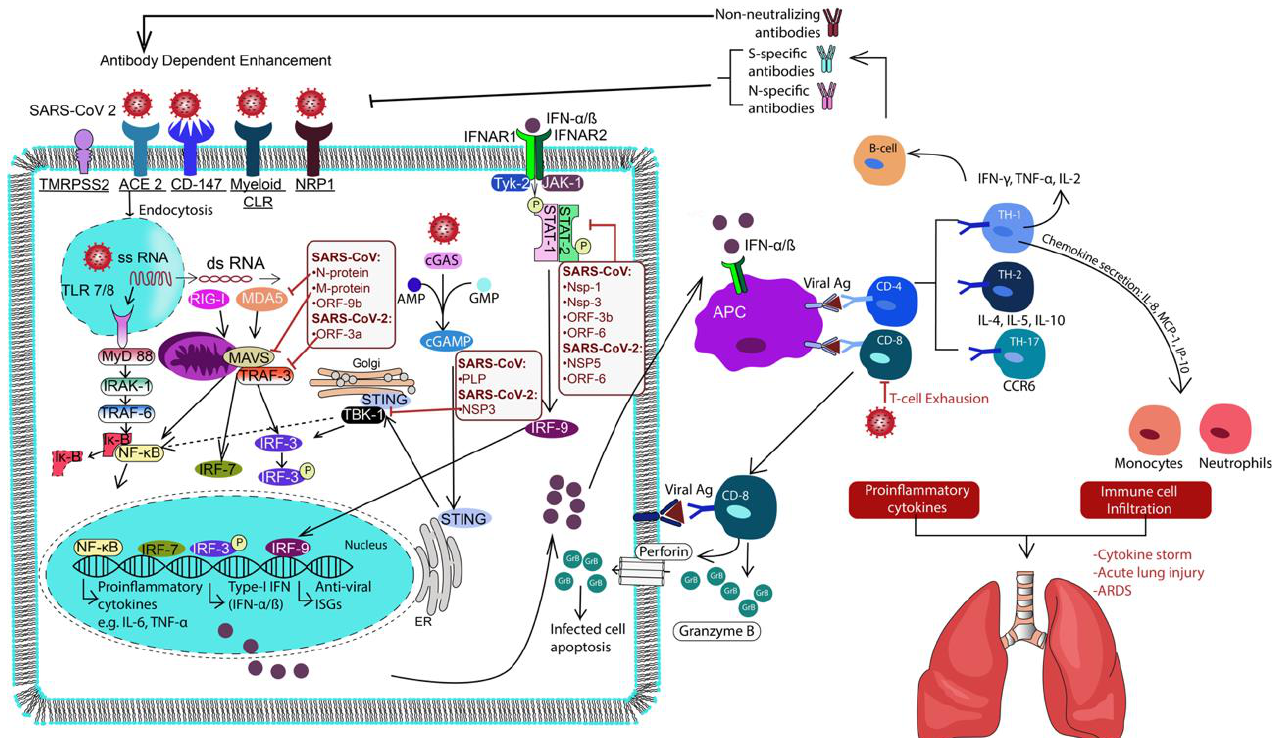
Figure 1. Schematic illustration overviewing Severe Acute Respiratory Syndrome Coronavirus-2 (SARS-CoV-2) infection mechanism and the host immune response post-infection. TMPRSS2, angiotensin-converting enzyme 2 receptor (ACE2) and CD147 play pivotal roles in the viral attachment and entry followed by post-infection and viral replication. Host immune defense begins sooner with the initiation of PRR signaling (TLRs, RLRs, CLRs and cGAS-STING) leading to activation of type I IFN along with proinflammatory cytokine. TLRs, Toll-like receptors; RLRs, RIG-1 like receptors; CLRS, C-lectin like receptors; cGAS-STING, cyclic GMP-AMP synthase-Stimulator of Interferon Genes; IFN, interferon.